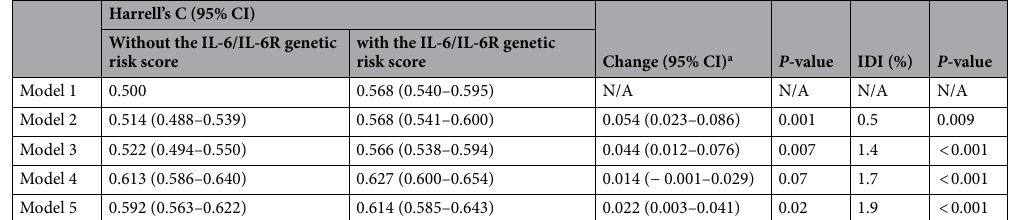
Table 6. Additive value of the IL-6/IL-6R genetic risk score in with rejection. Data are presented as Harrell’s concordance statistic (Harrell’s C) with 95% confidence interval (CI) and integrated discrimination improvement (IDI) with P -value. a Change in C-statistics compared to the model without the IL-6/IL-6R genetic risk score. Model 1 crude model. Model 2 rs2228145-C (previously rs8192284) in the donor. Model 3 adjusted for model 1 plus donor characteristic’s: donor age, donor sex, donor blood type, and donor origin. Model 4 adjusted for model 1 plus recipient characteristic’s: recipient age, recipient sex, recipient blood type and dialysis vintage. Model 5 adjusted for model 1 plus transplant characteristic’s: cold and warm ischemia time, the total HLA-mismatches, and the occurrence of delayed graft function